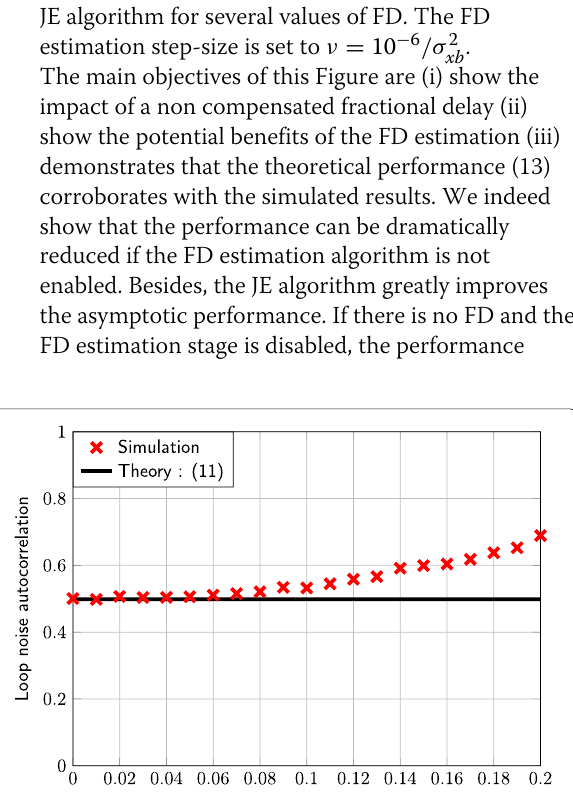
noisy signal (initial SIR of 0dB) due to the attenuation induced by the pollution. The complex gain algorithm is driven by a non interpolated reference u ( n ) defined with (5) and the JE algorithm uses a Farrow structure to apply the estimated FD to u ( n ) . We also assume a constant TxL channel, and we represent the performance of the complex gain estimator and the JE algorithm for several values of FD. The FD estimation step-size is set to ν = 10 − 6 /σ 2